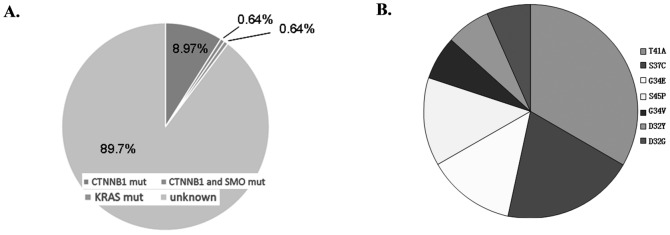
Statistical analysis of mutational information in the Chinese HCC patients.A: CTNNB1 mutation is the predominant mutagenic event. Of the 156 samples assessed, 15 cases (9.6%) were found to have CTNNB1 mutations. 14 cases (8.97%) had CTNNB1 mutation only, one case (0.64%) harbored CTNNB1 mutation and SMO (K575M) mutation, and one case (0.64%) had a KRAS (G12D) mutation. B: All of the mutations in CTNNB1 were clustered within the N-terminal region; five cases exhibited the T41A mutation, whereas three cases had the S37C mutation. The G34E and S45P mutations were found in two cases each, and the G34V, D32Y and D32G mutations were detected in only one case each in this study.